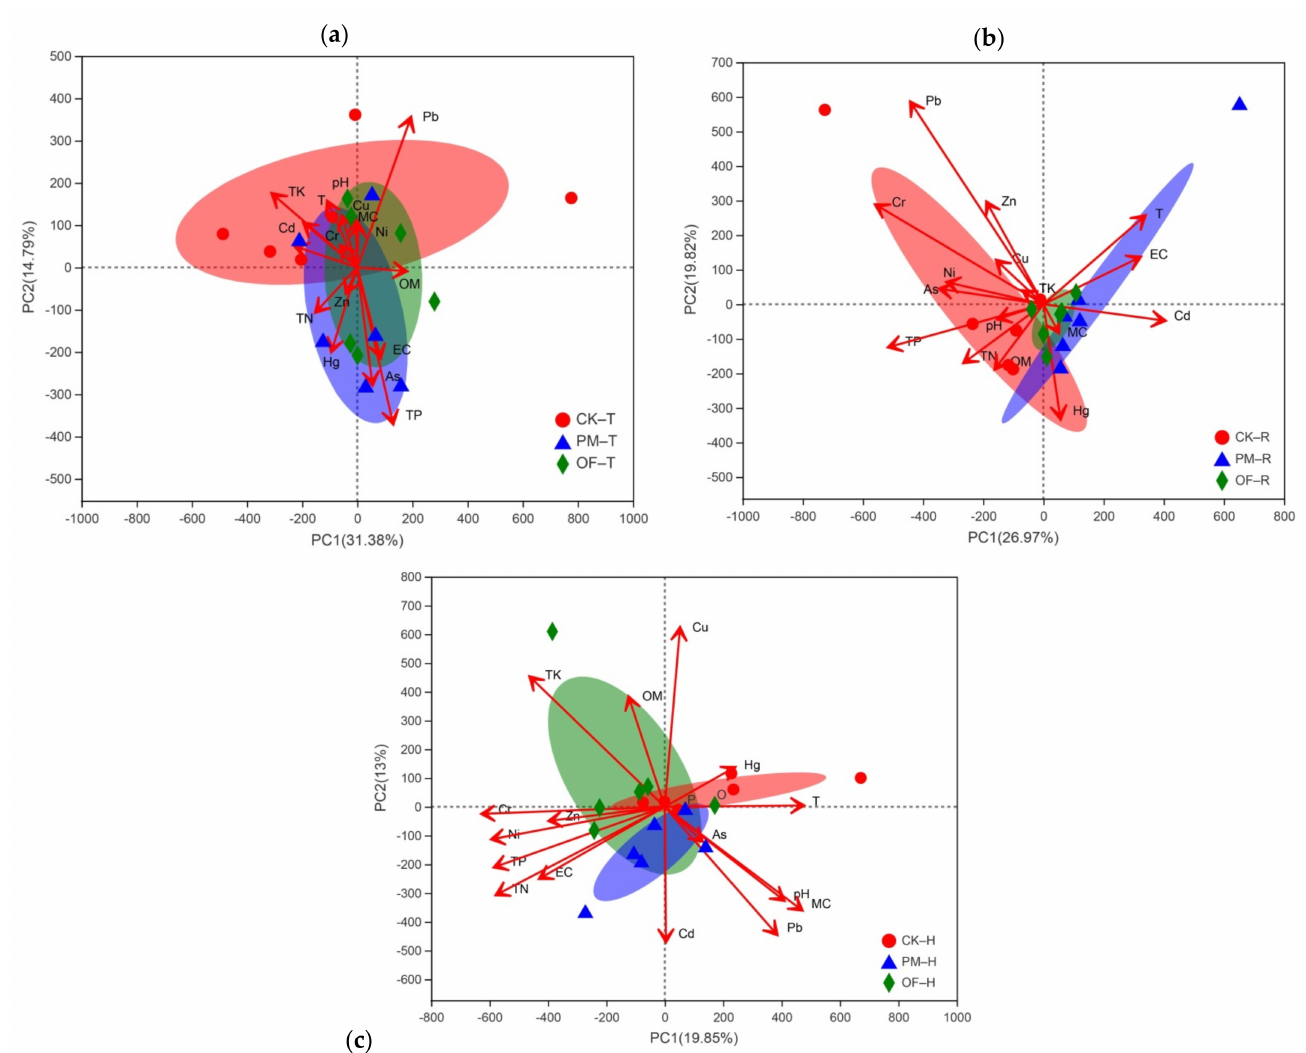
Figure 6. The PCA analysis with environmental factors of all treatment samples ( a ) tillering stage; ( b ) heading stage; ( c ) ripening